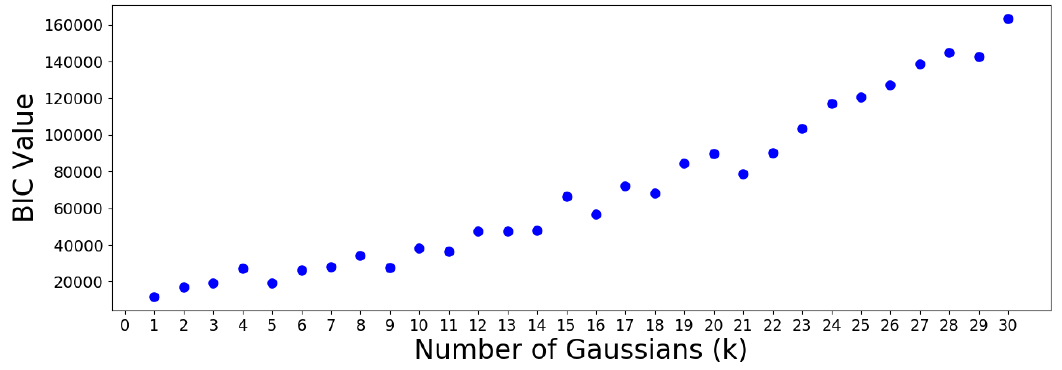
Figure 15. Bayesian information criterion (BIC) values for GMMs of cluster sizes 1 < K < 30. The minimum occurs at K = 1, indicating that one single group should be considered. This is an impractical result and is therefore discarded.